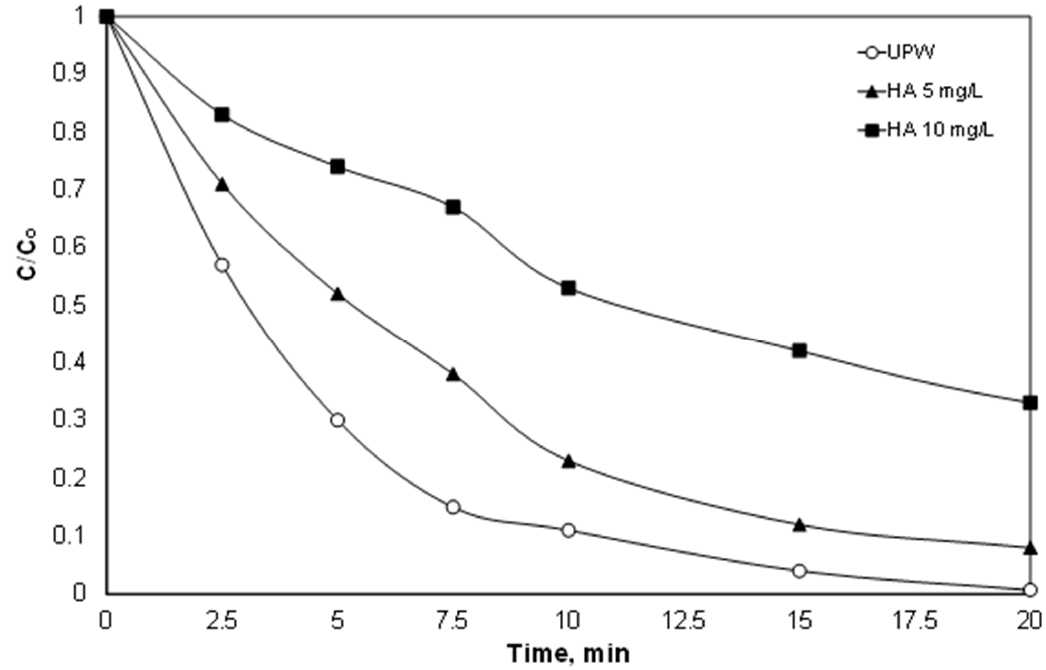
Figure 6. Effect of organic matter (humic acid) on the destruction of PIR. [PIR] = 500 μ g/L, [Fe 2+ ] = 2 2 mg/L, [SPS] = 20 mg/L, ultrapure water and inherent mg/L, [SPS] = 20 mg/L, ultrapure water and inherent pH.